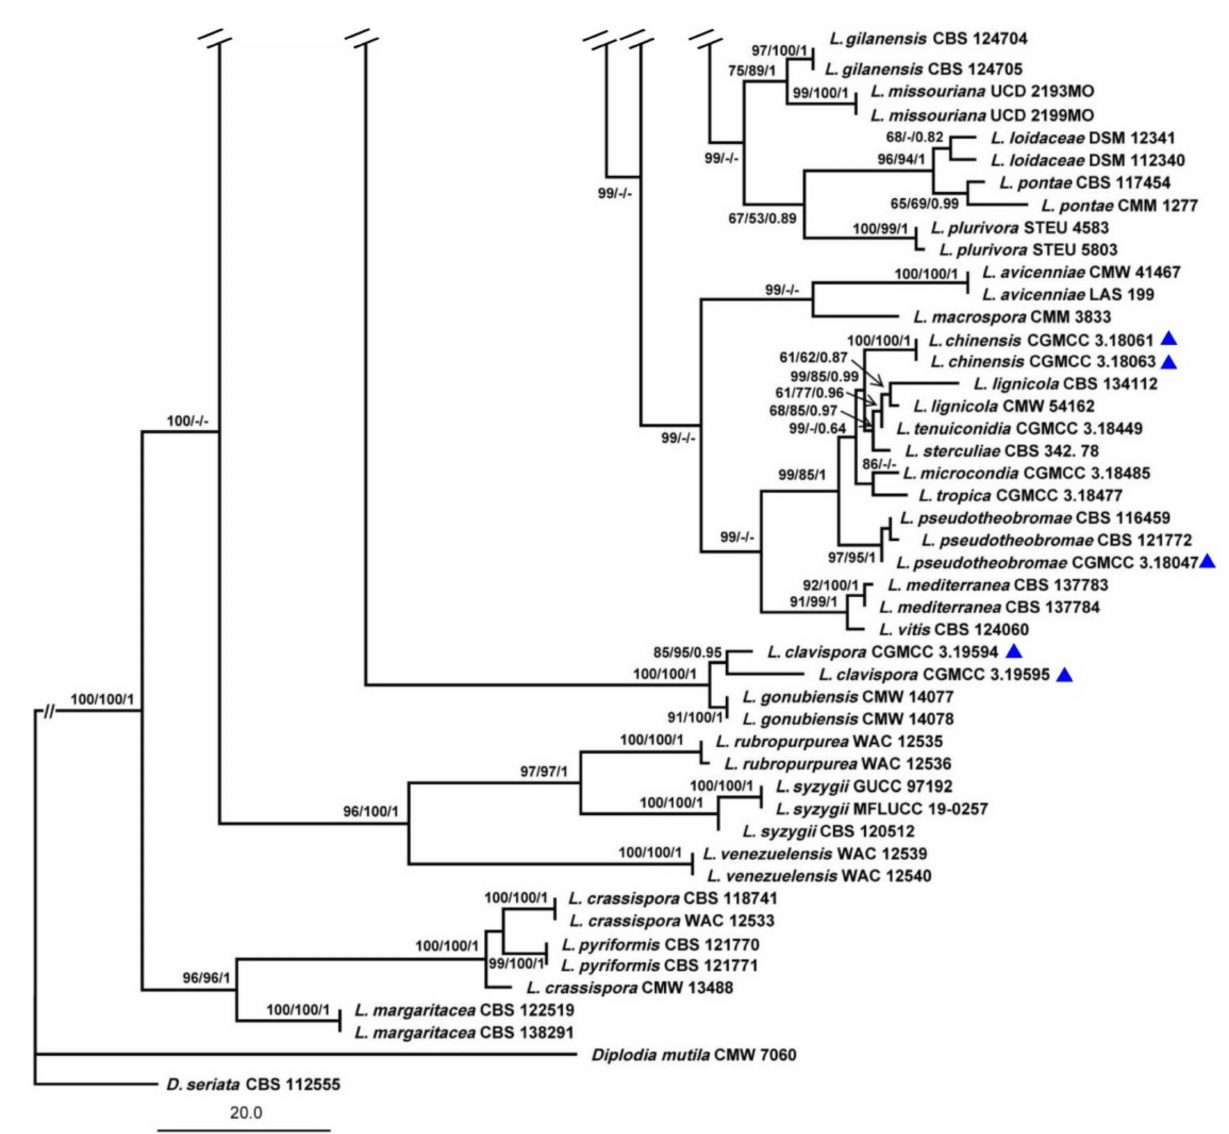
Figure 1. Maximum parsimony phylogram reconstructed from the combined sequences of ITS, TEF1- α , TUB2 and RPB2 of Lasiodiplodia . MPBP above 50% ( left ), MLBP above 50% ( middle ), BIPP above 0.7 ( right ) are indicated at the nodes. New species proposed are indicated in red font. The tree is rooted to Diplodia mutila and D. seriata . The strains isolated from samples of China are marked in blue